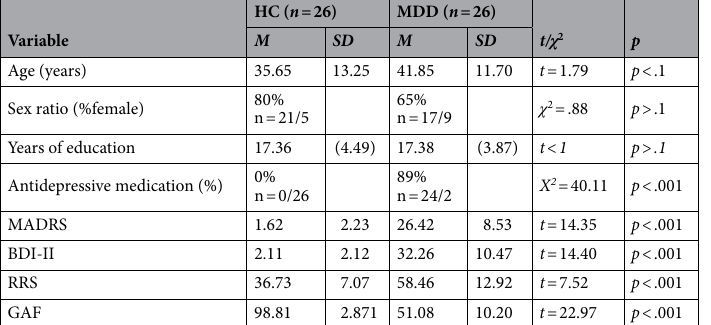
Table 1. Demographic variables of the depressed patients and healthy controls. MADRS the Montgomery- Åsberg Depression Rating Scale, BDI-II Beck Depression Inventory II, RRS Rumination Response Scale, GAF Global Assessment of functioning.